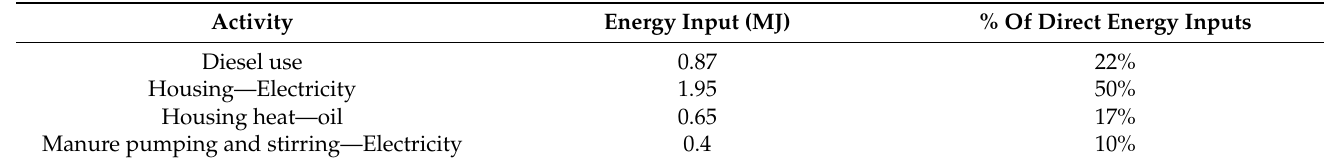
Table 3. Direct energy inputs in pig production systems according to activity (based on